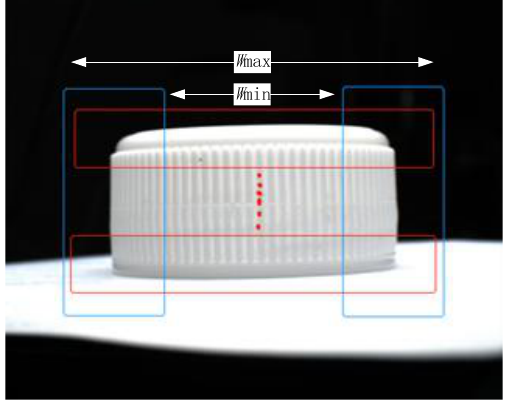
Figure 6. Edge extraction process.